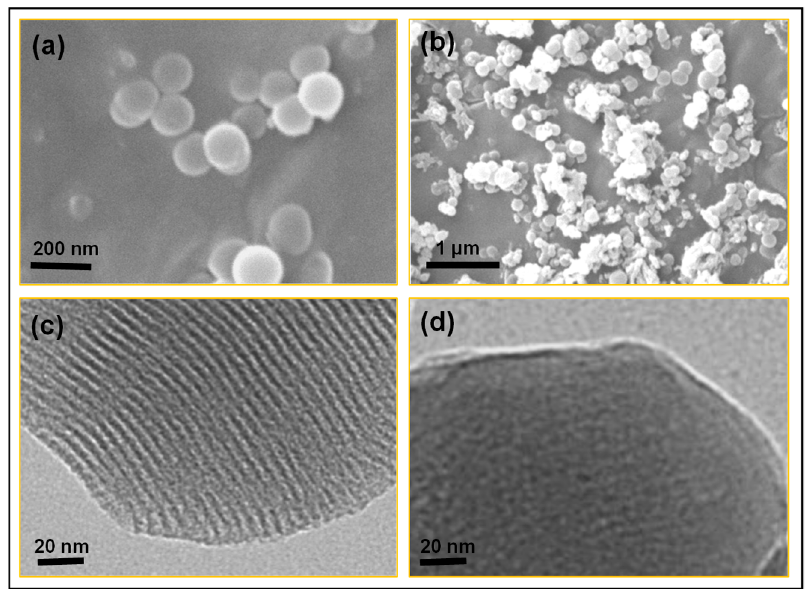
Figure 2. SEM images of ( a ) MS@GPTMS NPs and ( b ) MS@PNIPAm-PAAm NPs, without Dox loading, respectively. TEM images of ( c ) MS@GPTMS NPs and ( d ) MS@PNIPAm-PAAm NPs, respec- tively.